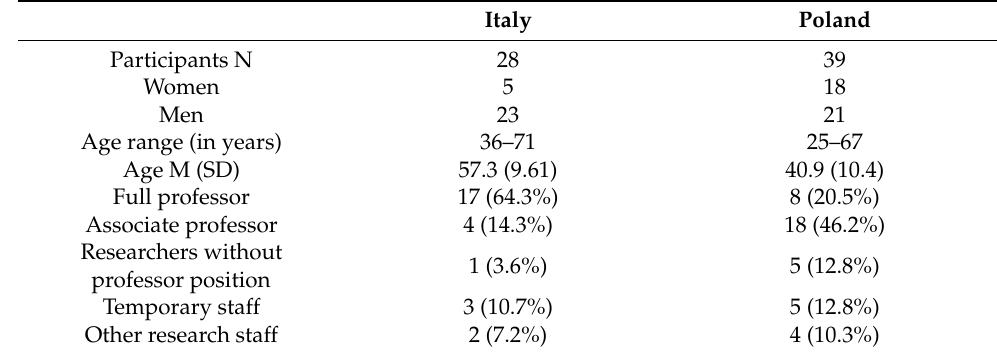
Table 1. Characteristics of respondents (N =